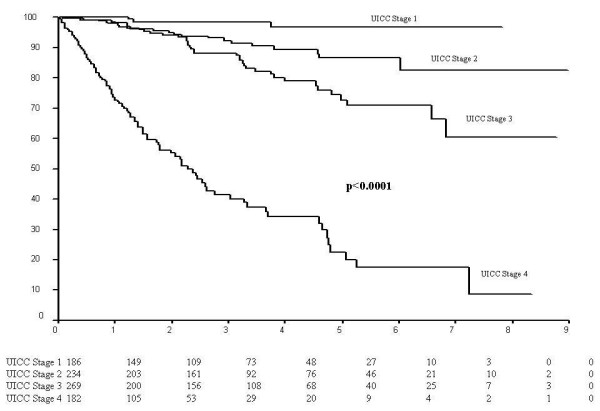
Survival according to UICC tumour stage (7 patients who died peroperatively were excluded from the analysis).